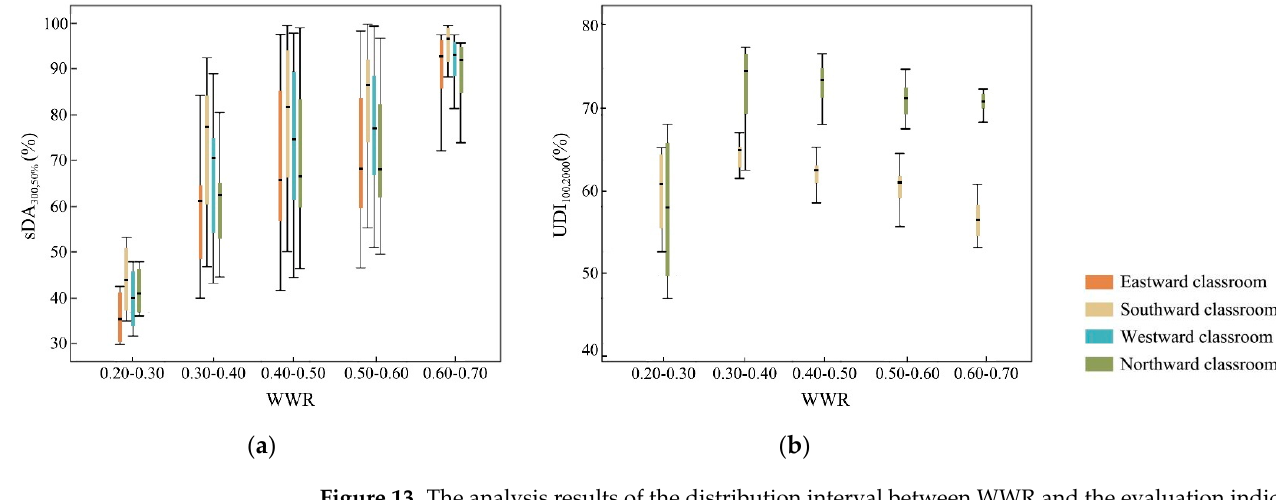
( b ) Figure 13. The analysis results of the distribution interval between WWR and the evaluation indices: ( a ) the analysis results of sDA 300,50% ; ( b ) the analysis results of UDI 100-2000 . In terms of the window–floor ratio, with the increase in WFR, the sDA 300,50% of the terrace classrooms facing each orientation showed a clear upward trend, and the median value of sDA 300,50% in the south-facing classroom was always the highest (Figure 14a).